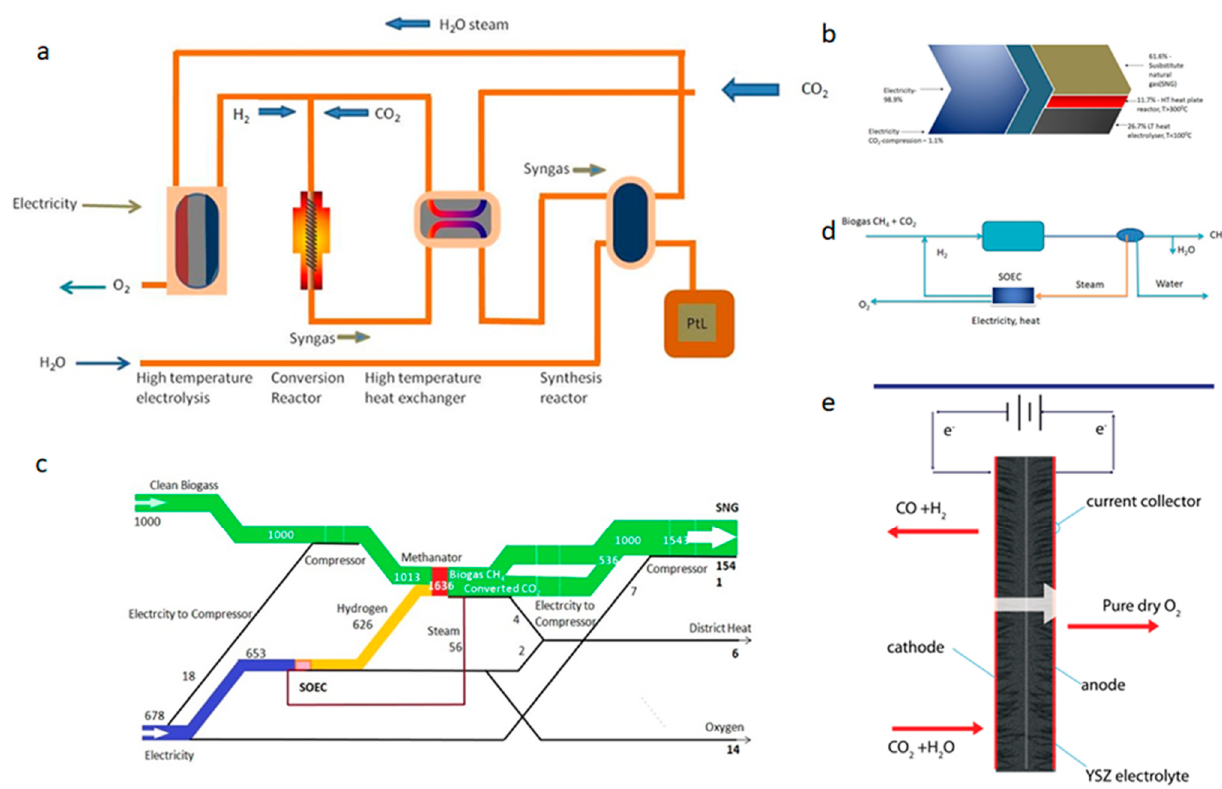
Figure 6. ( a ) Blue crude being produced by Sunfire process. ( b ) Rate of energy conversion for ETOGAS process. ( c ) SOEC and TREMP system energy. ( d ) Integral SOEC and TREMP − TM systems. ( e ) The figure is the pictorial representation of the solid oxide co-electrolyzer (SOCE) cell.